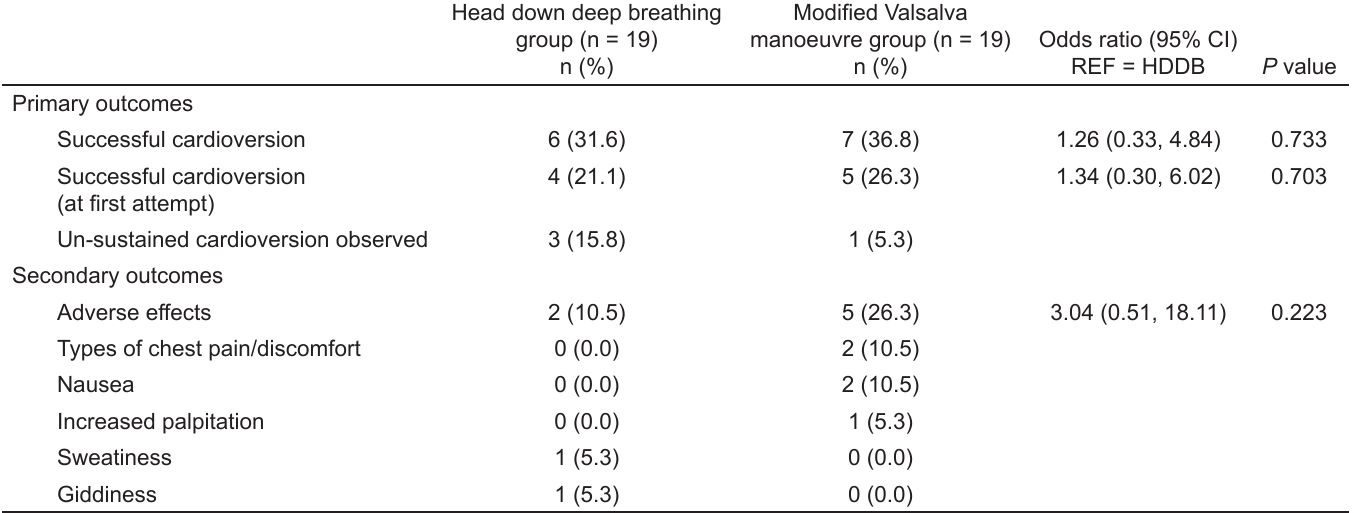
Table 2. Primary and secondary